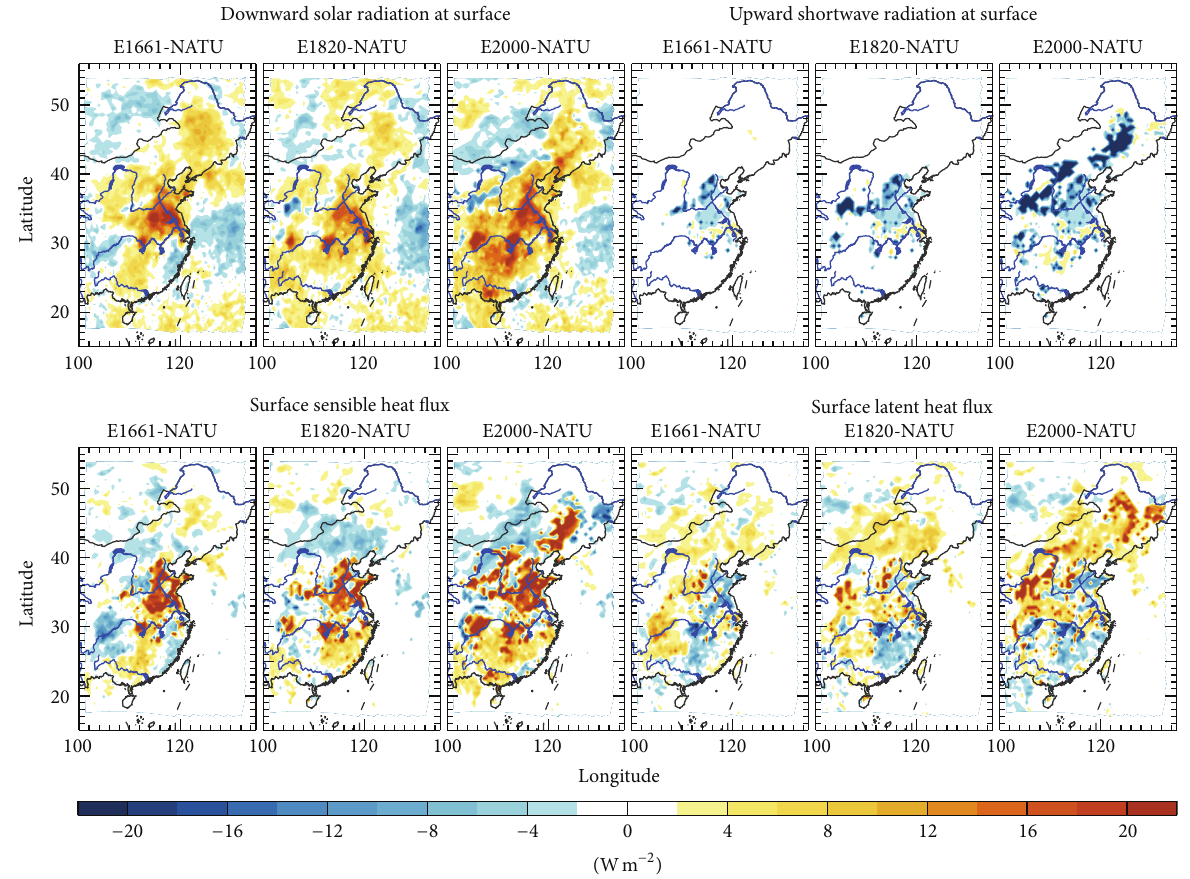
Figure 5: Changes in surface downward solar radiation, reflected shortwave radiation at the surface, surface sensible heat flux, and latent heat flux induced by land cover conversions from natural vegetation to cropland in 1661, 1820, and 2000.